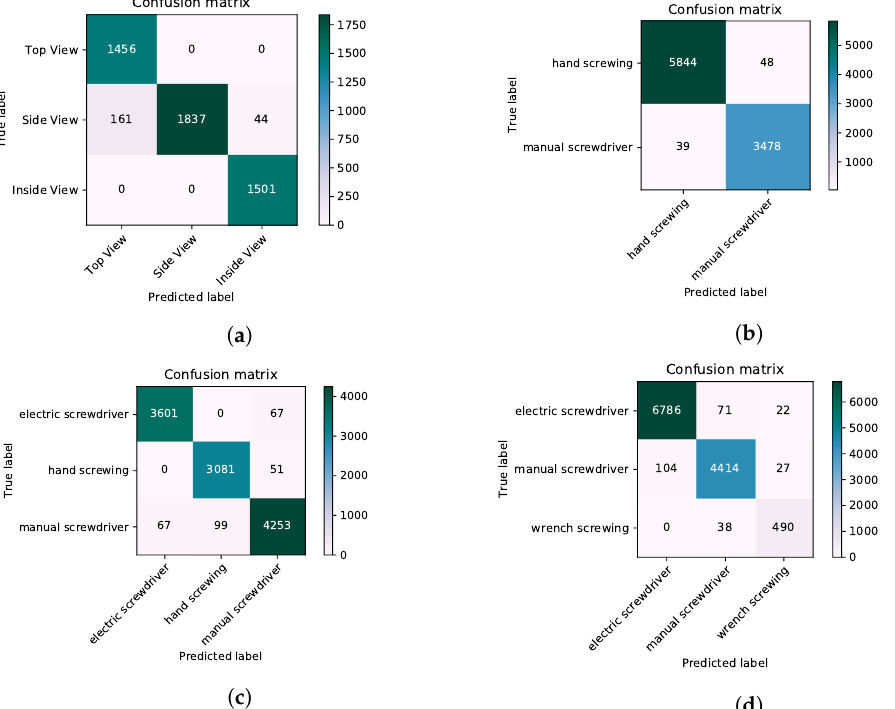
Figure 12. Confusion metrics of activities classified by the Inception-V3. ( a ) confusion matrices of classification done by Inception-V3 on worker’s position. ( b ) If the worker is working on the top side, these are the actives that the worker performed. ( c ) Side of the ATM activities classification confusion metrics. ( d ) confusion matrices on the activities performed inside the